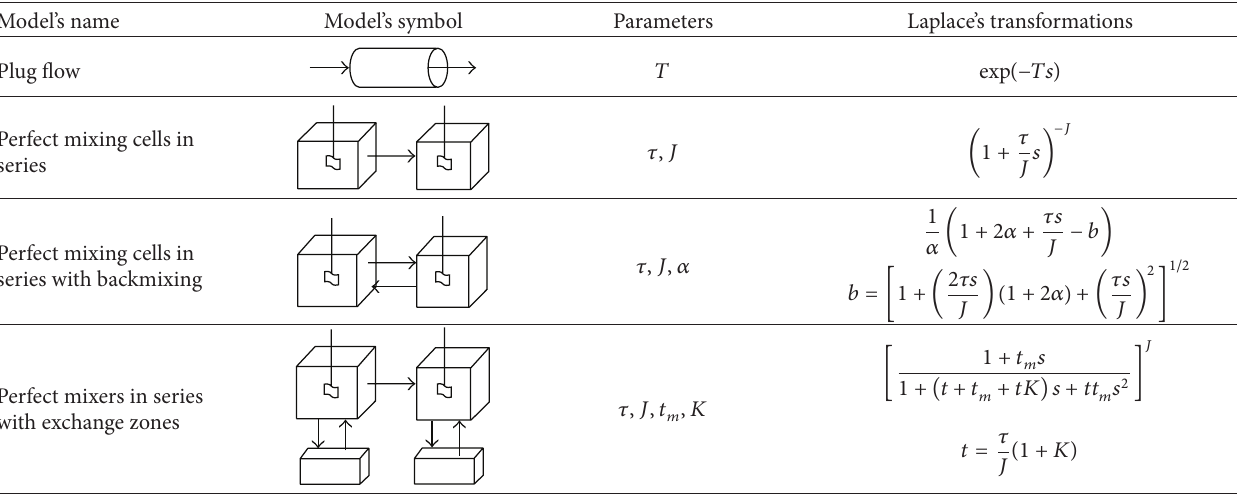
Table 1: Elementary models used in experimental RTD data analysis